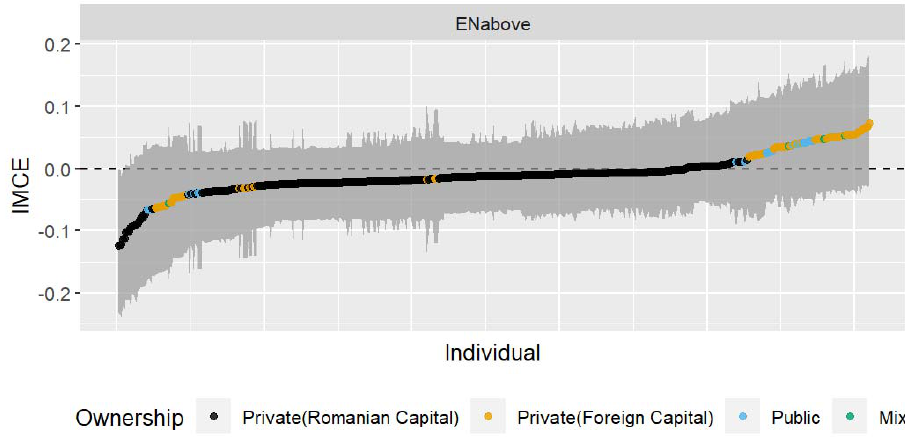
Figure 5. Heterogeneity in IMCE’s by company ownership covariate.